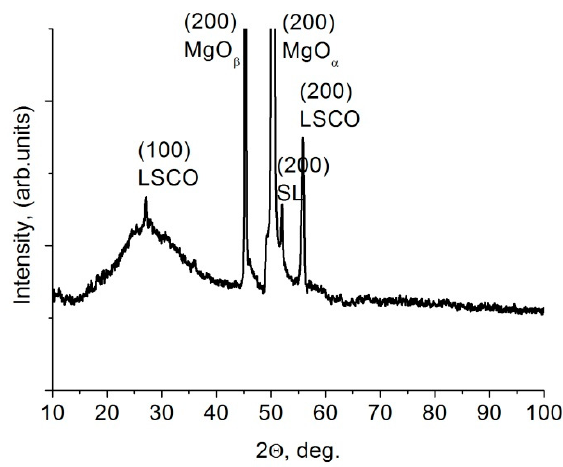
Figure 1. Diffractogram of barium zirconate–barium titanate superlattice.